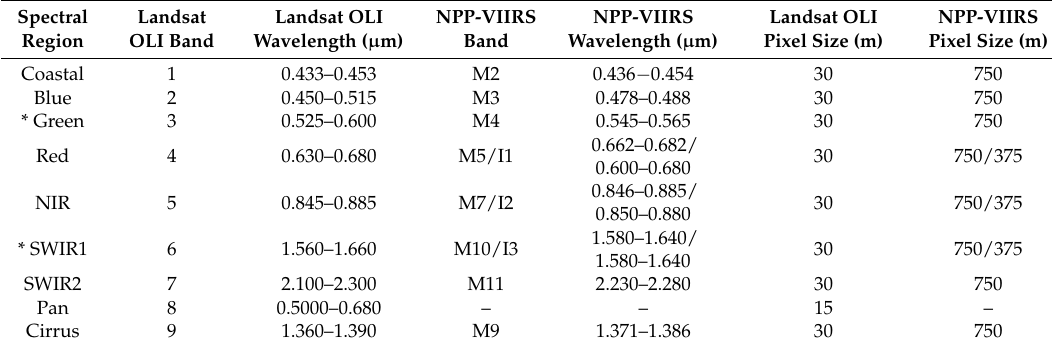
Table 1. Corresponding band list of Landsat OLI and Suomi NPP-VIIRS.